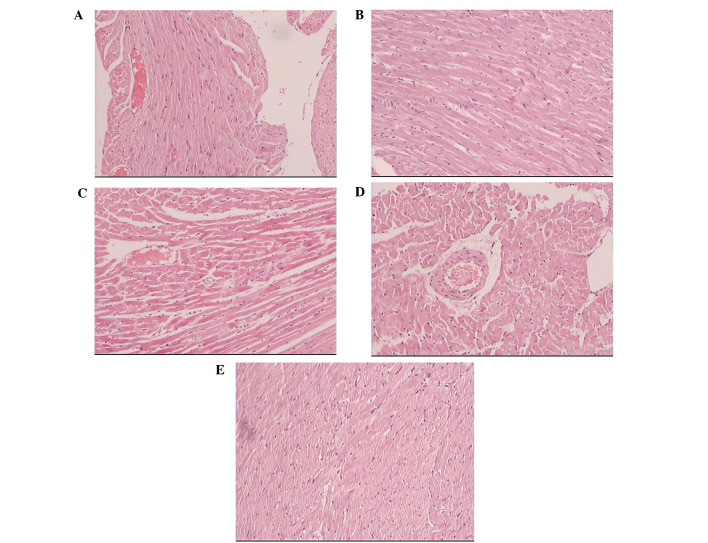
Urocortin alleviated myocardial fibrosis in DCM (HE stain; magnification, ×400). (A) Control; (B) DM; (C) UCN; and (D) UCN + AST and (E) UCN + TRI groups. DCM, diabetic cardiomyopathy; HE, hematoxylin and eosin; DM, diabetes mellitus; UCN, urocortin; AST, astressin.